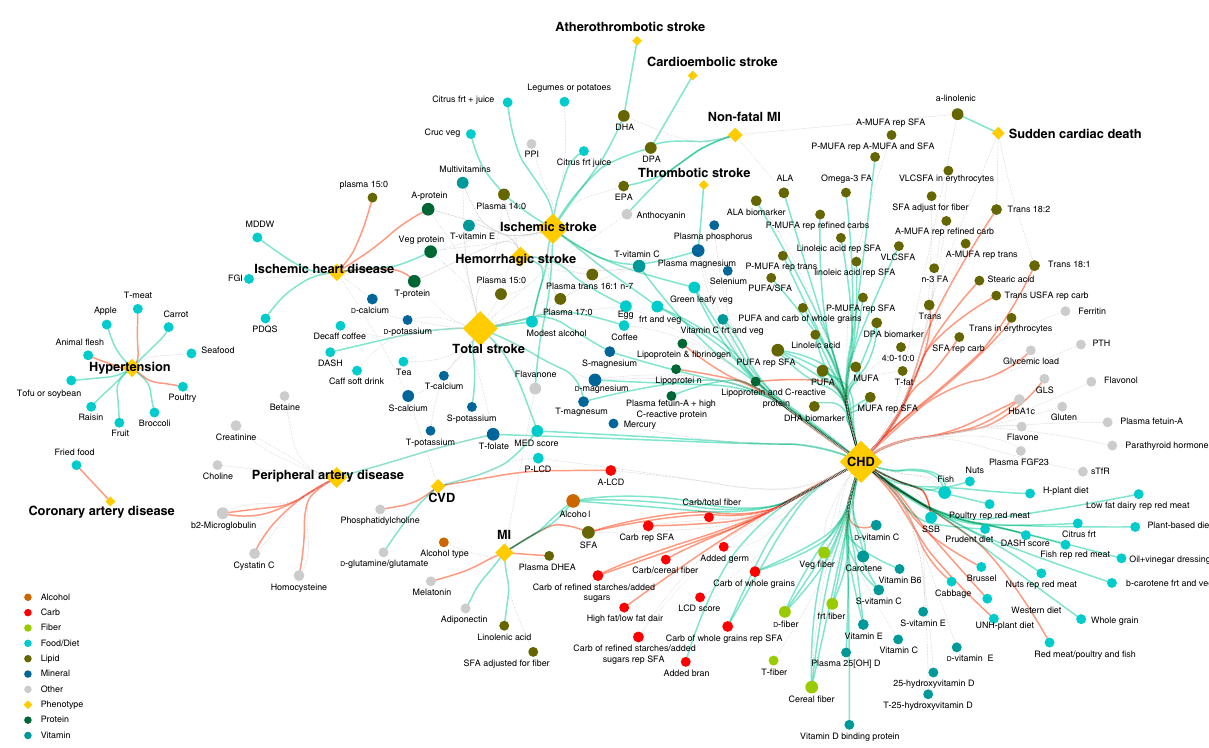
Fig. 1 The Knowledge Graph of the Dietary Factors Associated with Cardiovascular Disease in the NHS Data. The nodes of the graph are dietary exposures (circles) and cardiovascular diseases (diamonds) as two sets of nodes. Each studied association is shown by an edge whose color denotes the “ direction ” (i.e., positive or negative) of the association. Green and red links indicate negative and positive associations, respectively, between an exposure and a disease. Grey links denote associations that were studied but not found to be statistically signi fi cant. In the context of NHS, CHD refers to non-fatal MI and fatal coronary heart disease; also, coronary artery disease (CAD) refers to non-fatal MI and fatal coronary artery disease. Cardiovascular disease (CVD) is de fi ned as a composite of coronary artery disease and non-fatal or fatal stroke. Source data are provided in Source Data - Figure 1.xlsx. The fi gure aims to illustrate the body of work derived from NHS data on cardiovascular diseases. A detailed comparison of the result of our analysis with previous NHS-related work and other fi ndings in the literature is provided in the section “ Comparison with the literature ”